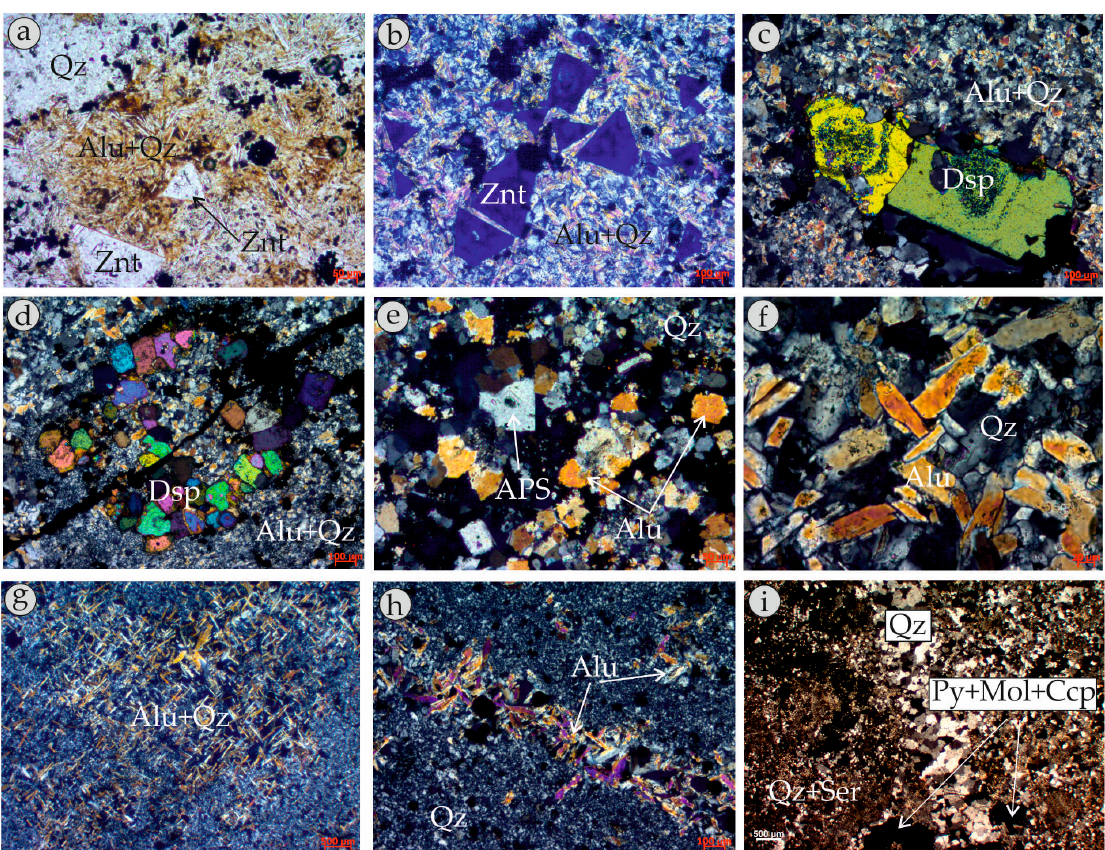
Figure 4. Transmitted light microphotographs of alteration assemblages from the Konos Hill area, NE Greece. ( a , b ) Euhedral zunyite (Znt) crystals in association with quartz and tabular alunite (Alu + Qz, plane-polarized and crossed-polarized light, respectively); ( c ) Subhedral diaspore (Dsp) crystals displaying concentric zonation patterns (crossed polarized light); ( d ) Subhedral diaspore (Dsp) crystals set in an alunite (Alu) and quartz (Qz) matrix of altered granodiorite (crossed-polarized light); ( e ) APS crystals form the core of pseudocubic alunite (crossed-polarized light); ( f ) Tabular alunite crystals in association with quartz (Qz, crossed-polarized light); ( g ) Alunite (Alu) aggregate replacing a phenocryst in the granodiorite (crossed-polarized light); ( h ) Alunite (Alu) crystals forming veinlets in the quartz (Qz)-dominated matrix (crossed-polarized light); ( i ) Sugary quartz (Qz) crystals in porphyry-style vein hosting pyrite–molybdenite–chalcopyrite ore (Py + Mol + Ccp) in sericite-altered granodiorite (crossed-polarized light).